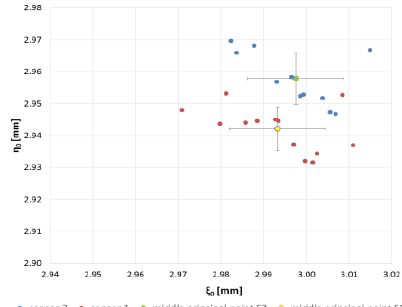
Figure 5 Distribution of the Principal Point coordinates considering T1.